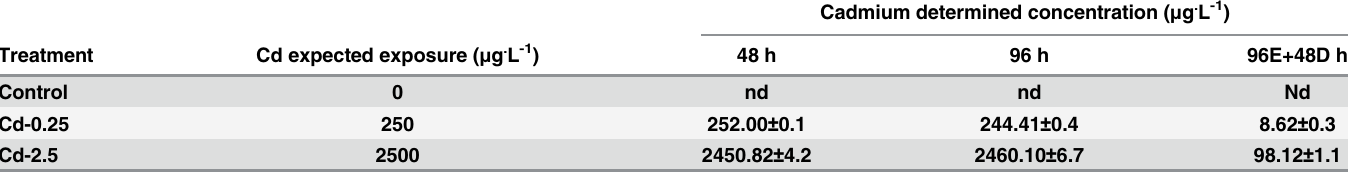
Table 3. Expected and determined concentrations (means ± S.D.) of cadmium in water obtained from the aquaria during the experimental